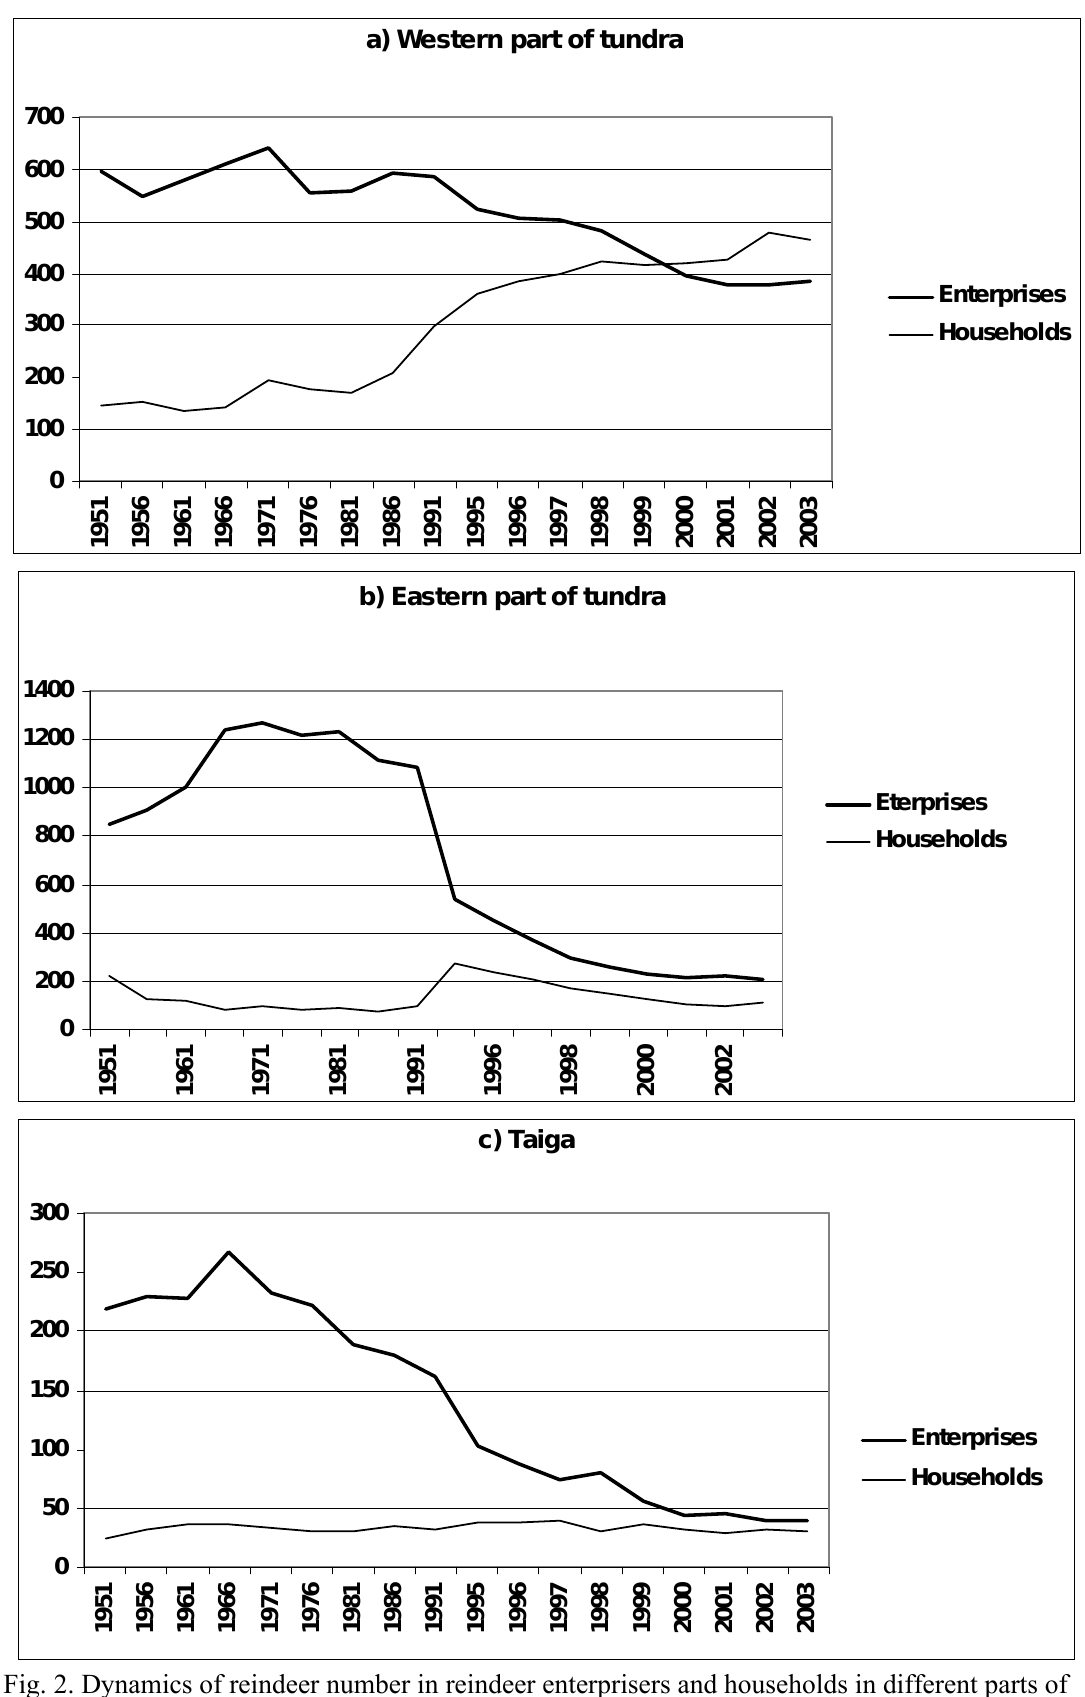
Fig. 2. Dynamics of reindeer number in reindeer enterprisers and households in different parts of Russia, animal number in